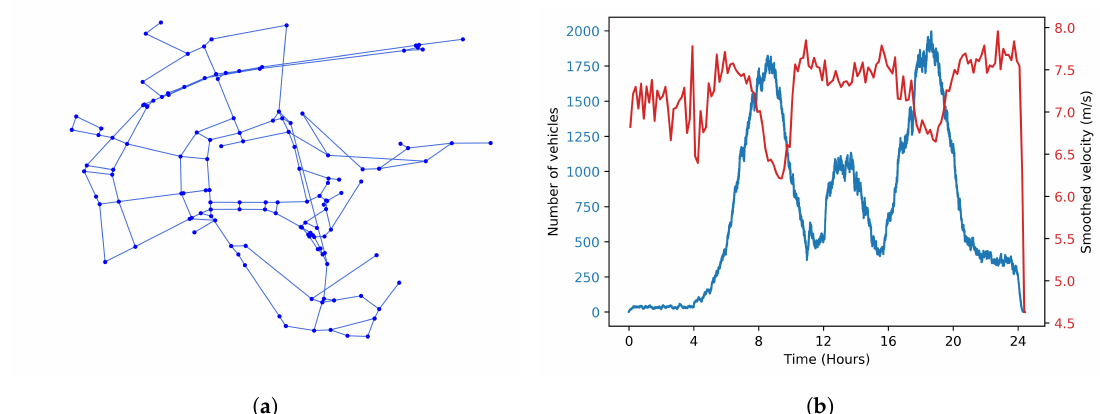
Figure 6. Considered Mobility Scenario. ( a ) Extracted graph; ( b ) Mobility information.